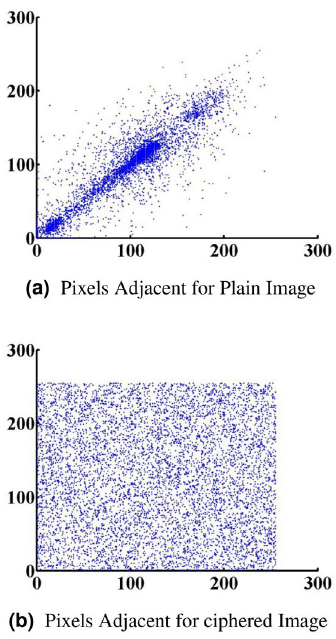
Figure 9. Pixels adjacent for plain and cipher image 41